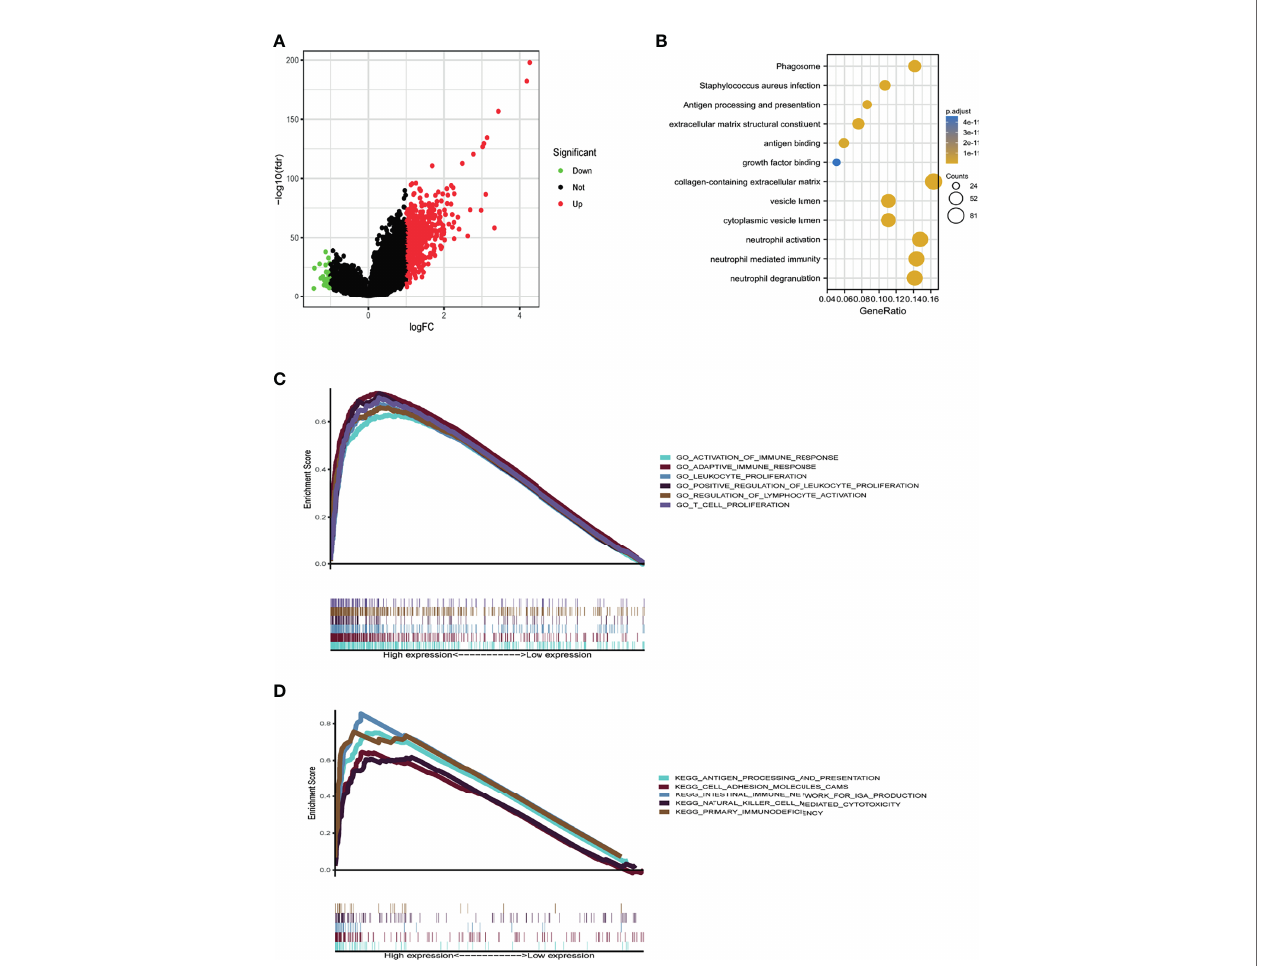
FIGURE 5 | Database for Annotation, Visualization and Integrated Discovery (DAVID) and gene set enrichment analysis (GSEA) of the relevant mechanisms involved in IGHG1 . (A) Volcano map showing the differentially expressed genes. (B – D) DAVID (B) , Kyoto Encyclopedia of Genes and Genomes (KEGG) (C) , and Gene Ontology (GO) (D) were used to analyze the relevant